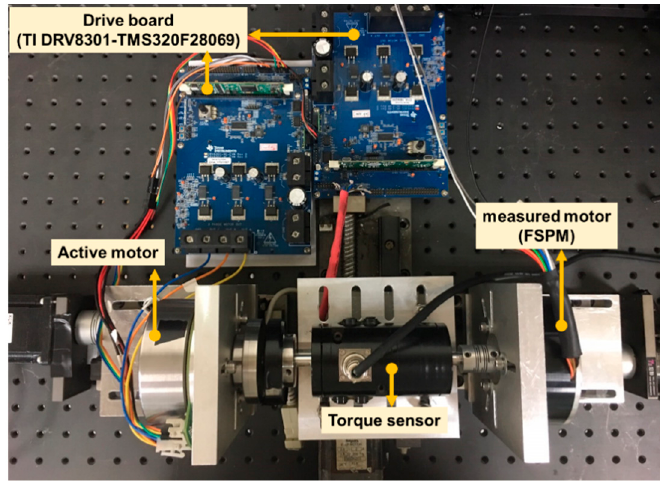
Figure 6. Schematic diagram of experimental setup.